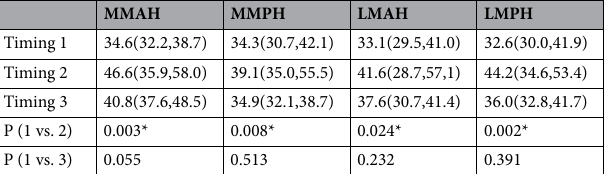
Table 2. Comparison of T2 values in each subregion at different timings [M (P25,P75)] (ms). *Statistically significant difference ( P <